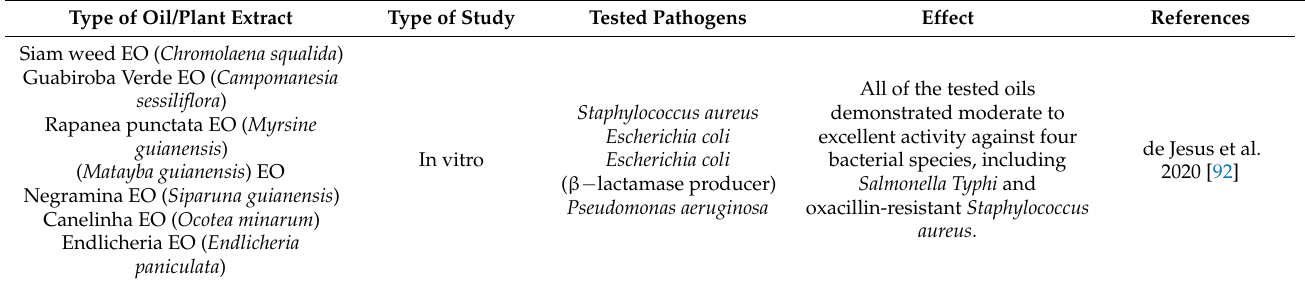
Table 1. Summary of recent studies regarding the use of essential oils (EO) and plant extracts against mastitis pathogens. Type of Oil/Plant Extract Type of